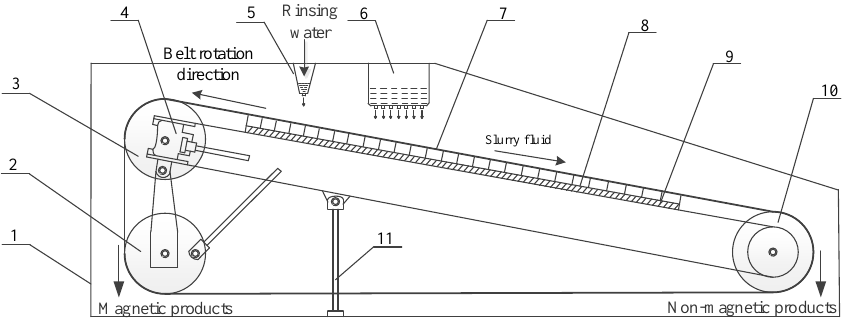
Figure 1. Flat plate high gradient magnetic separator. 1—Support frame; 2—Drive wheel; 3—Belt pulley; 4—Belt tensioning mechanism; 5—Water tank; 6—Feeding box; 7—Belt; 8—Plate magnet; 9—Steel plate; 10—Drive roller; 11—Inclination adjustment mechanism.